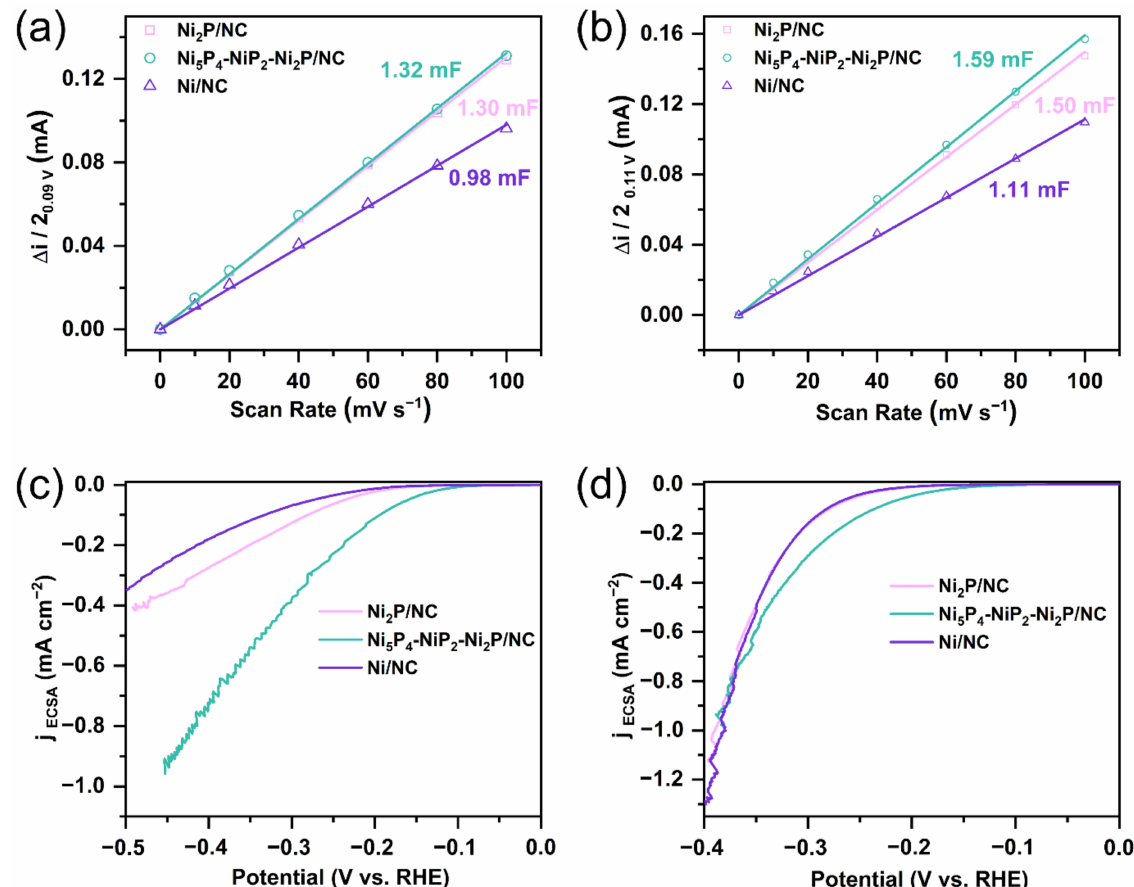
Figure 7. The capacitive currents of three samples were fitted as a function of scan rates from 10 mV s − 1 to 100 mV s − 1 in ( a ) 0.5 M H 2 SO 4 and ( b ) 1 M KOH solutions; the polarization curves normalized by ECSA for the three catalysts in ( c ) 0.5 M H 2 SO 4 and ( d ) 1 M KOH